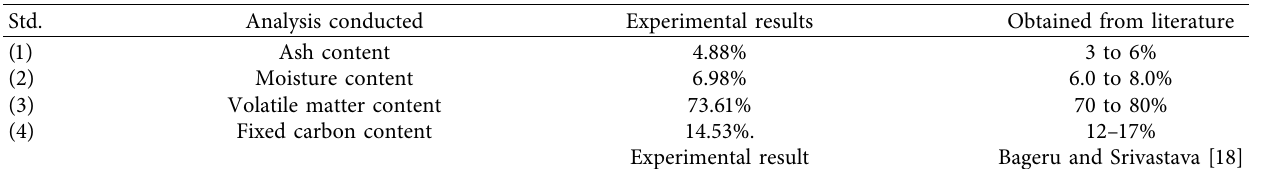
Table 2: Proximate analysis experimental results for Teff straw.